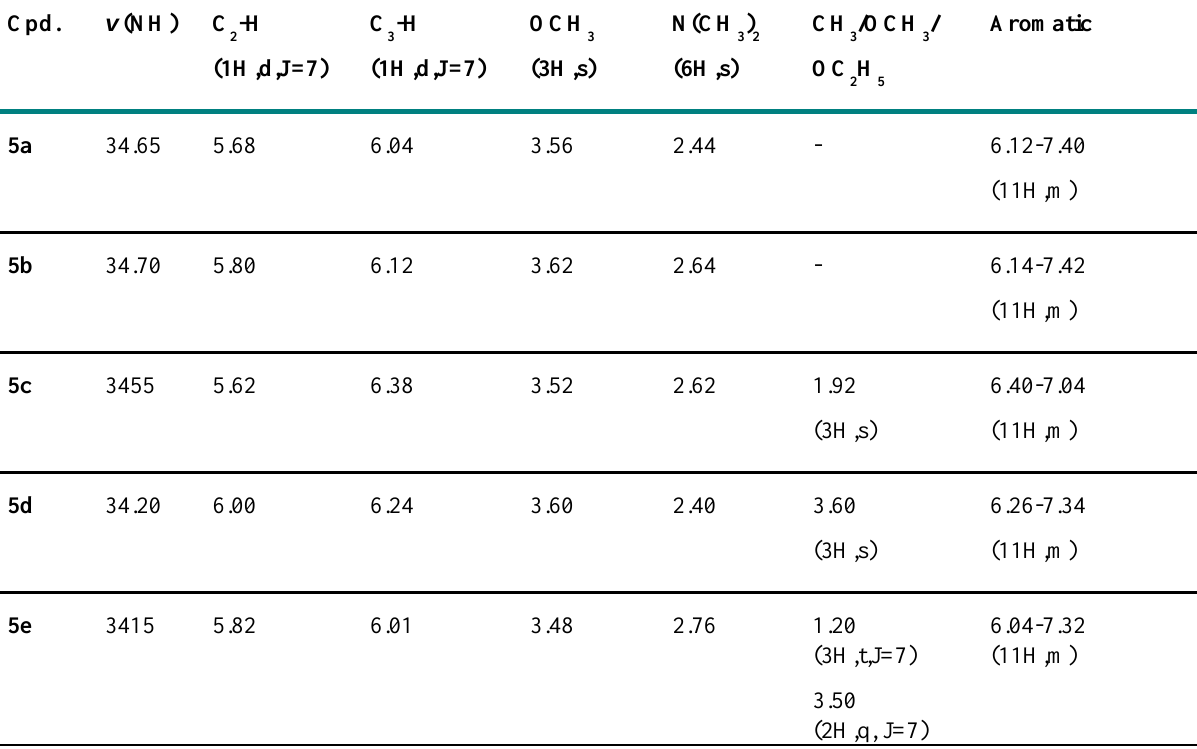
Table 2. Characteristic IR (cm -1 ), 1 H NMR ( d scale; J in Hz, solvent CDCl of 2,4-diaryl-2,5-dihydro-8-substituted-1,5-benzothiazepines ( 5a-e ).